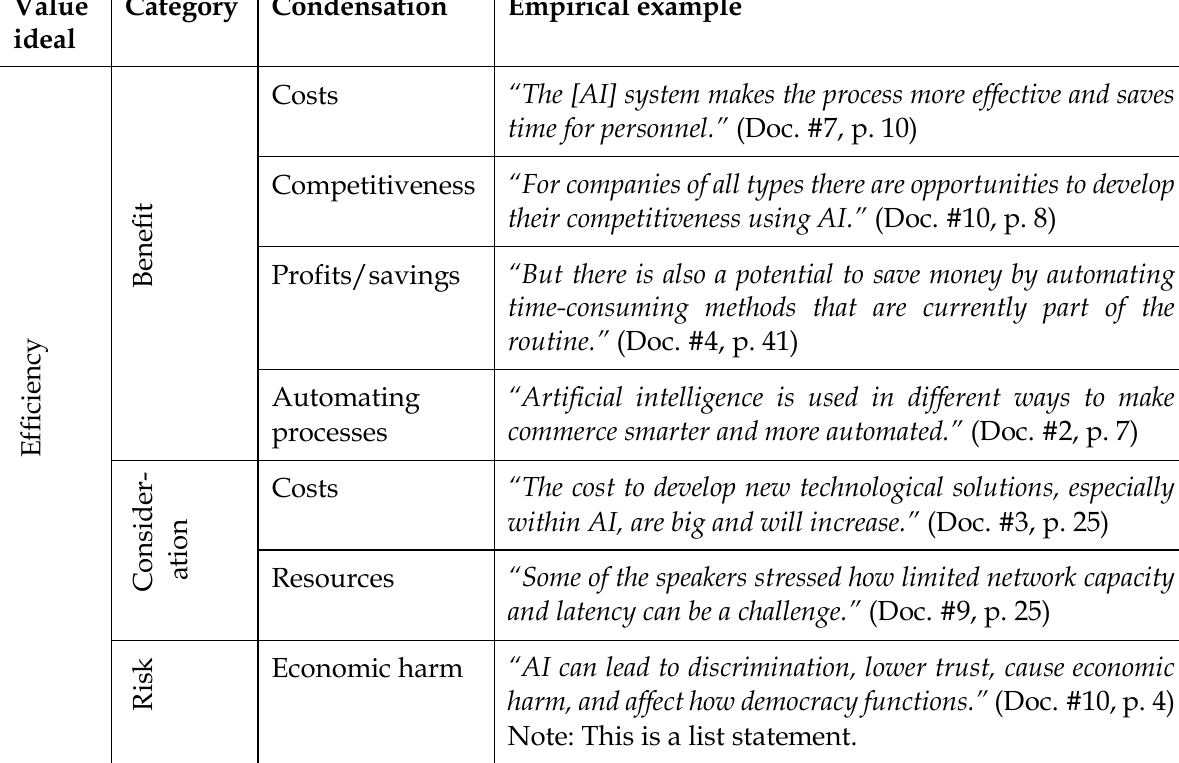
Table 4 . Empirical examples of condensations and their categories for the ‘Efficiency’ value ideal. Value ideal